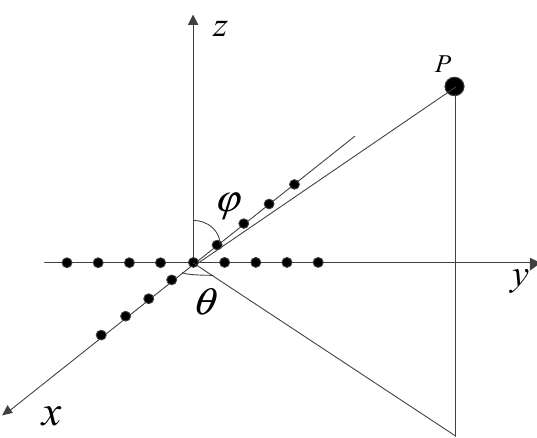
Figure 2. Mills Cross array with nine transmit and nine receive elements.